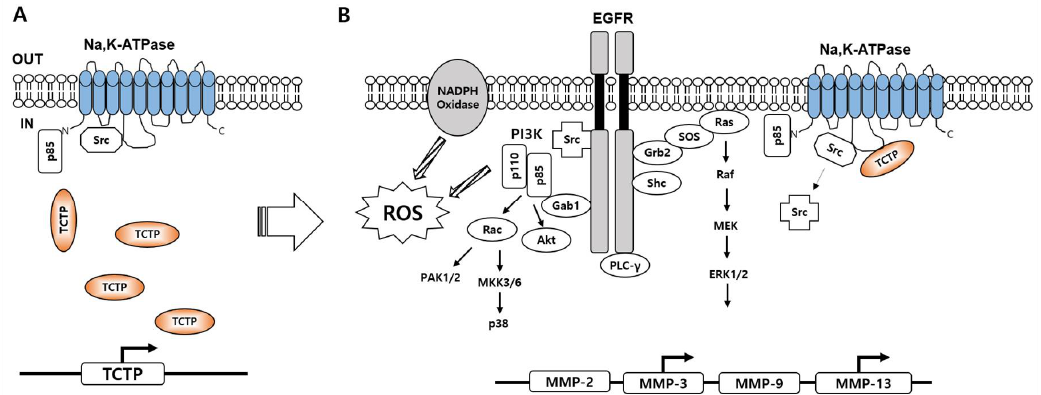
Figure 2. A schematic overview of TCTP-induced Na,K-ATPase signaling pathways. ( A ) PI3K